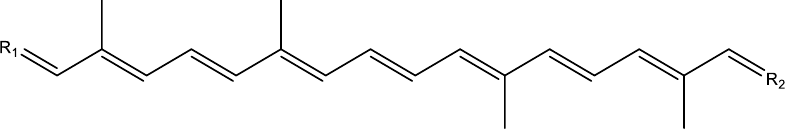
Figure 2. General formula of carotenoids.